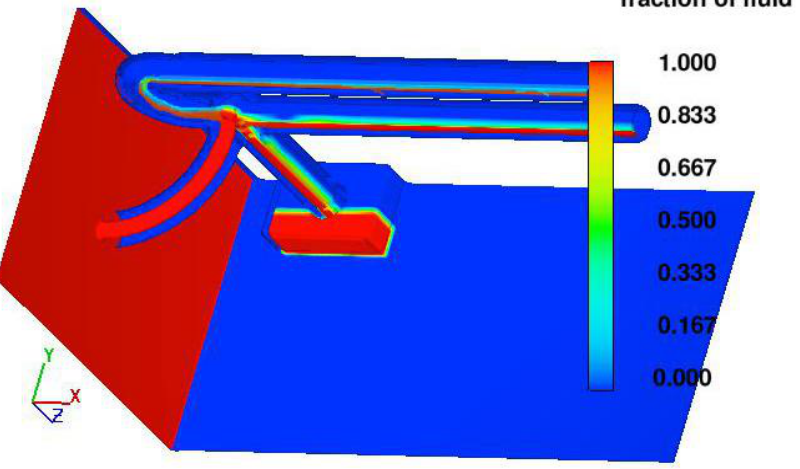
Figure 7. Automatic termination of flow by balancing input D hydrostatic pressure with back pressure from water accumulation in basin A. Figure from [2], pp. 291–292.